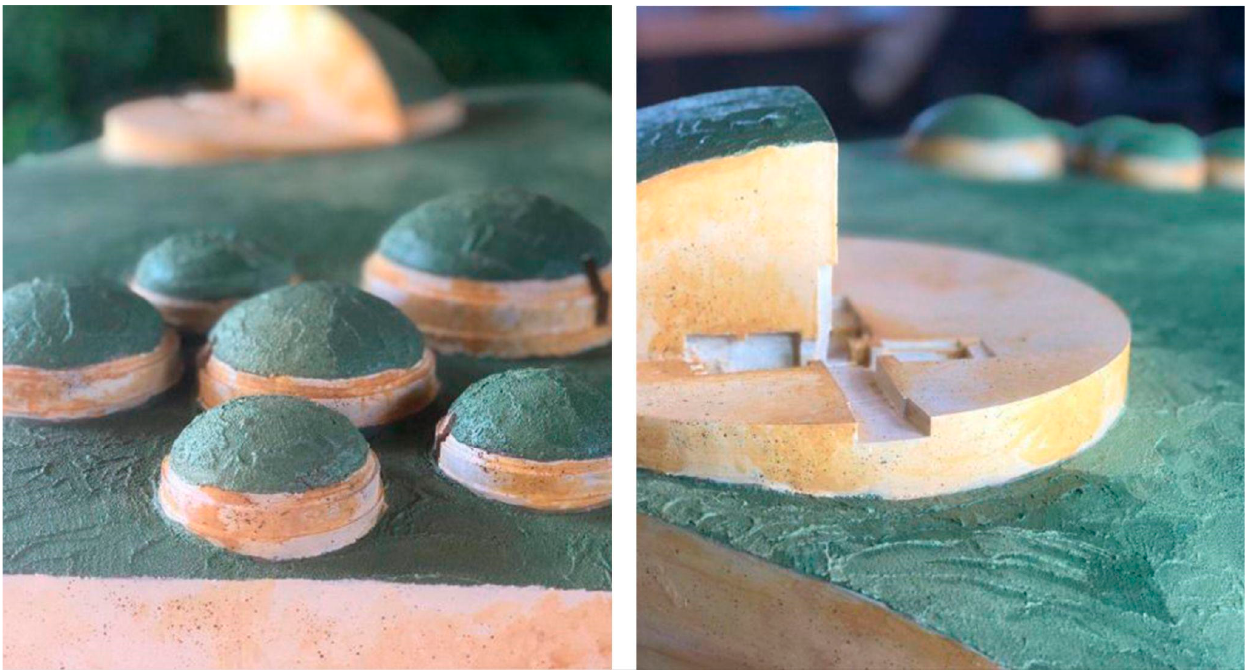
Figure 7. Image of 3D-printed models for the tangible user interface in Cerveteri (3D models by CNR IPSC; 3D print by Collettivo Digitale).